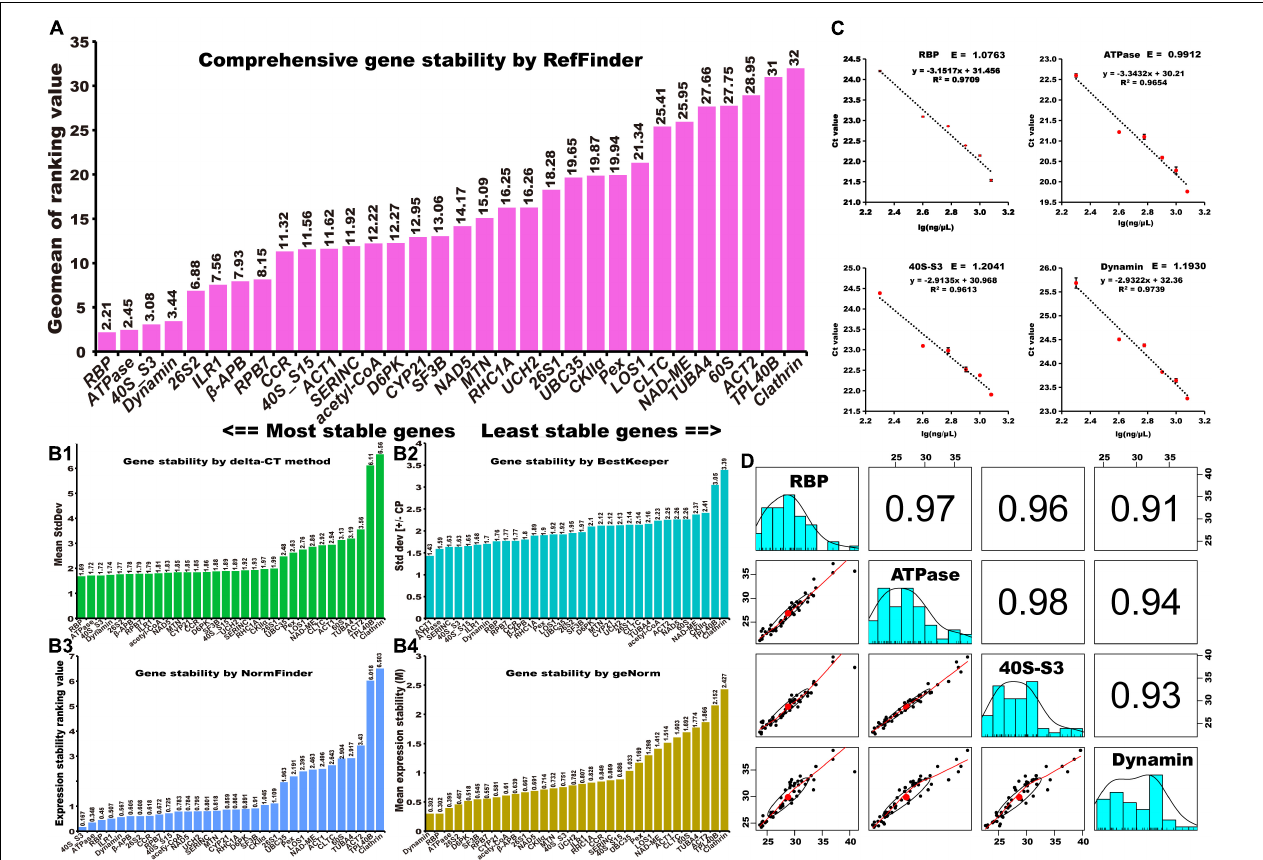
FIGURE 2 | Identification of stable reference genes. Stability rankings of candidate reference genes across samples using five calculation methods: (A) RefFinder, (B1) delta-CT, (B2) BestKeeper, (B3) NormFinder, and (B4) geNorm. (C) The PCR regression coefficient, R 2 , and PCR amplification efficiency, E, of RBP , ATPase , 40S-S3 , and Dynamin . (D) The stability of RBP , ATPase , and 40S-S3 was pairwise compared by surveying their expression levels in multiple tissues of three ginger cultivars under five kinds of stress treatments.